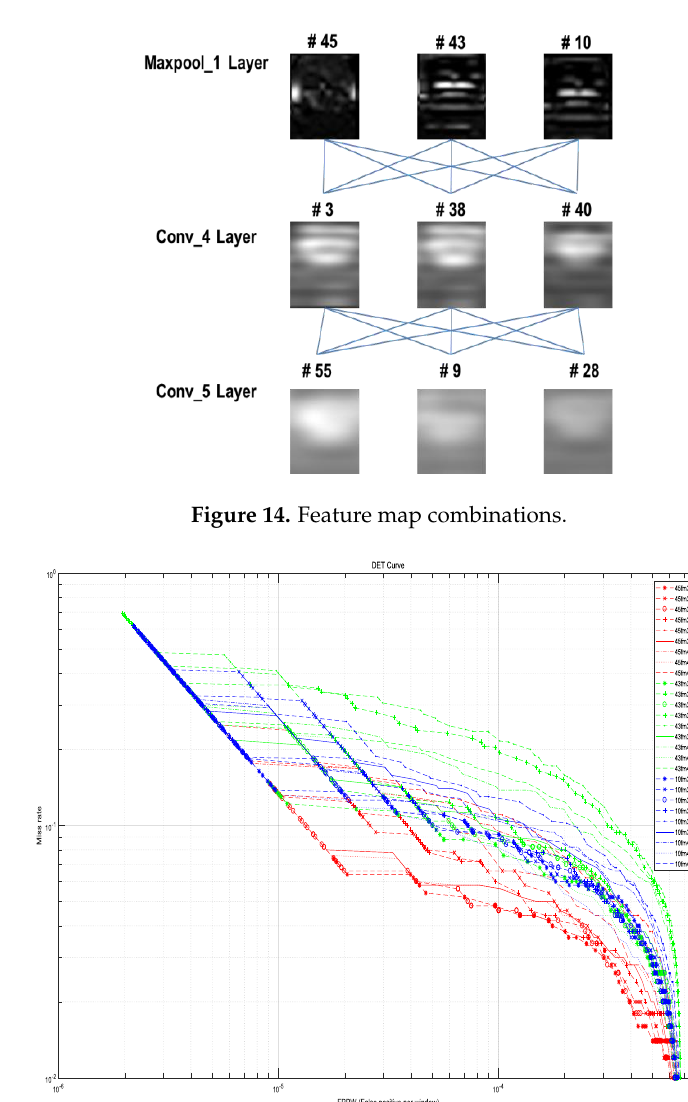
Figure 15. Feature map combination performances.